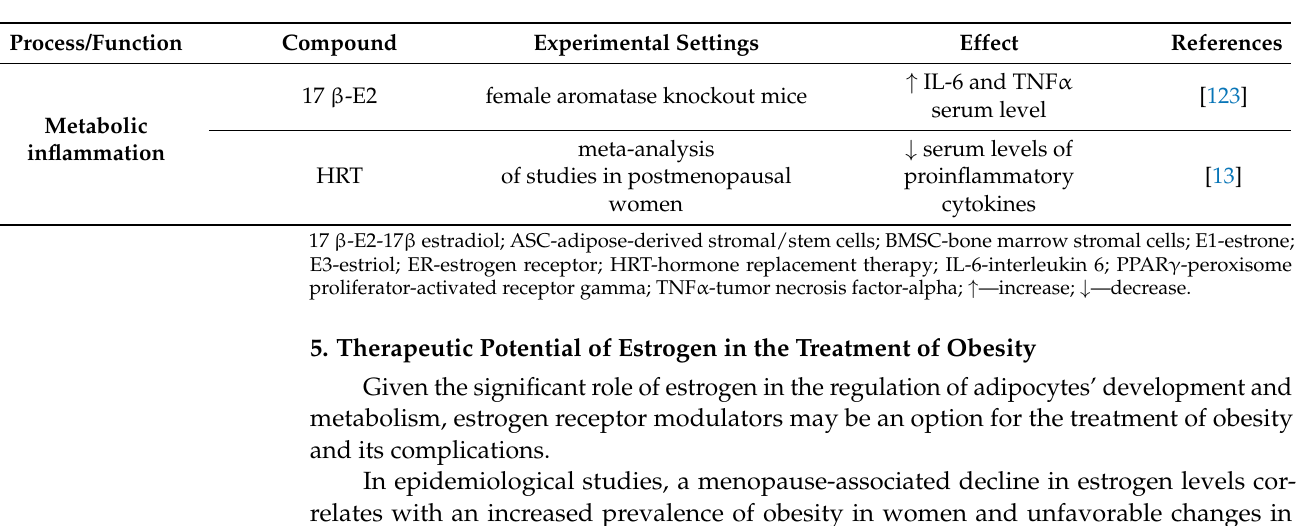
Table 3. Role of estrogens in the regulation of adipogenesis and adipose tissue